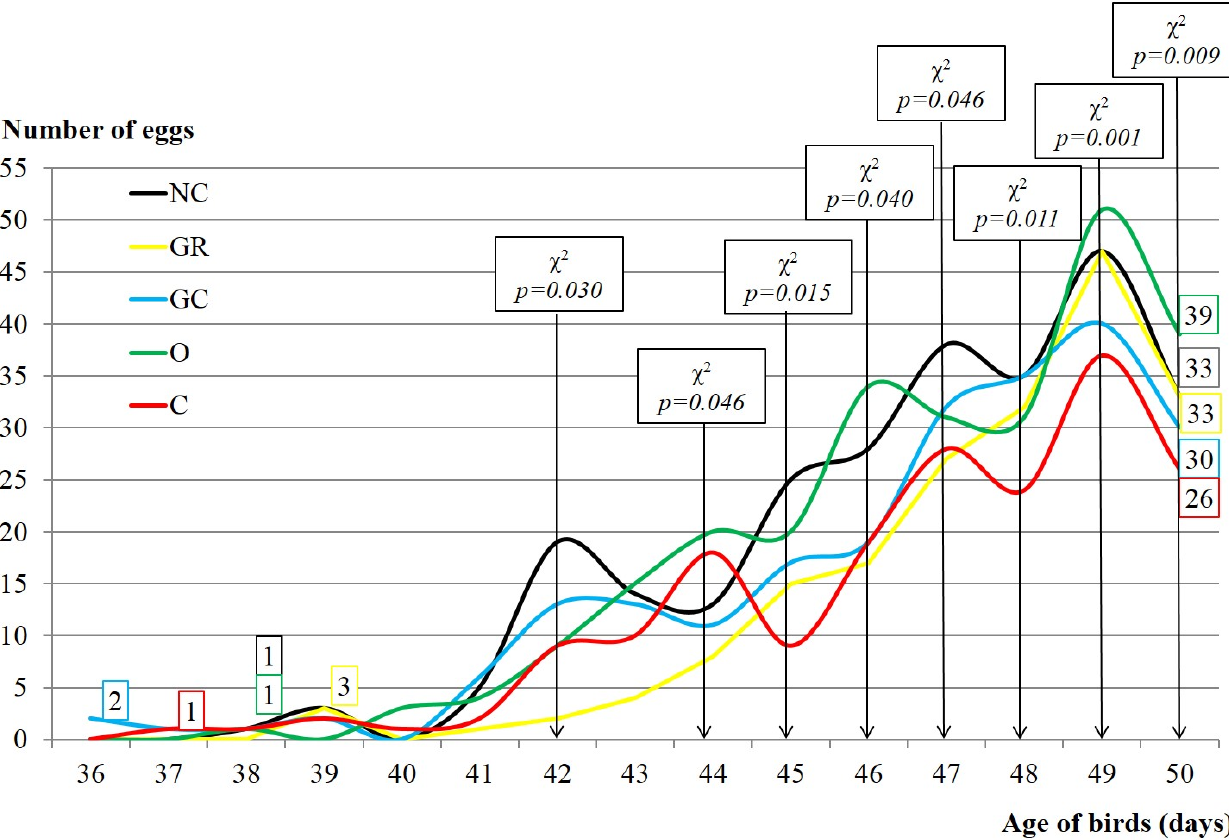
Figure 1. Sexual maturity and number of collected eggs of Japanese quails influenced by in ovo injection with aqueous solutions of plant extracts (200 per group with 5 replications). NC – negative control; GR – ginger; GC – garlic; O – oregano; C – cinnamon.